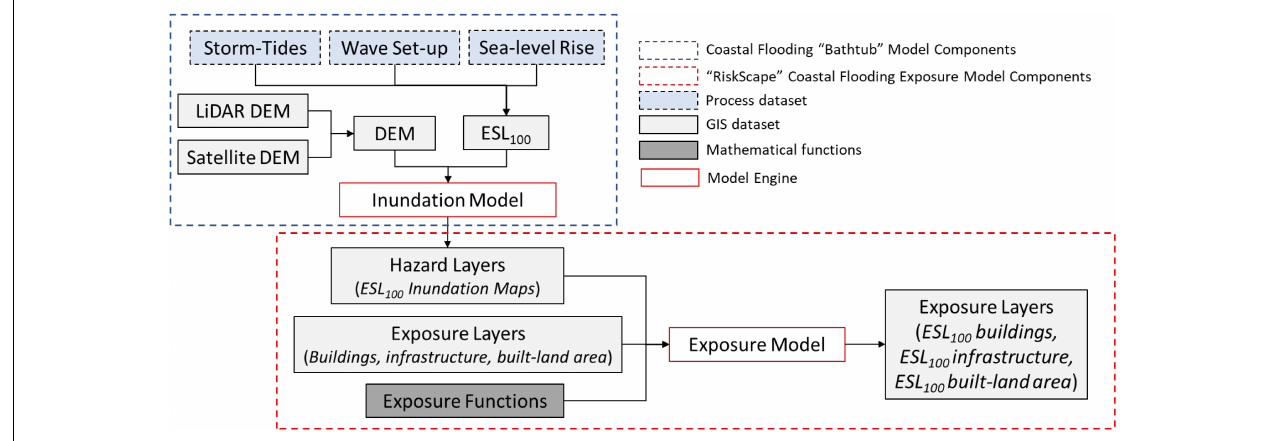
FIGURE 6 | RiskScape model framework applied by Paulik et al. (2020). ESL100 = 100-year average recurrence interval extreme sea-level. DEM = digital elevation model. Adapted from Paulik et al. (2020).